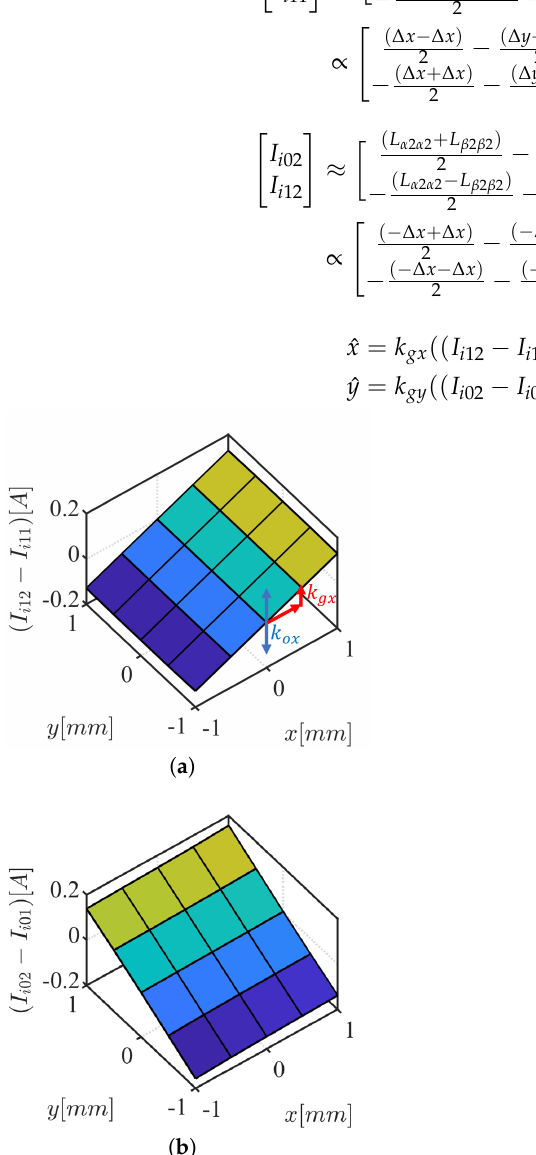
Figure 9. FEA results of differential HF currents, V HF = 1 V, f HF = 1000 Hz, and gain and offset constant, k gx and k ox . ( a ) ( I i 12 − I i 11 ); ( b ) ( I i 02 − I i 01